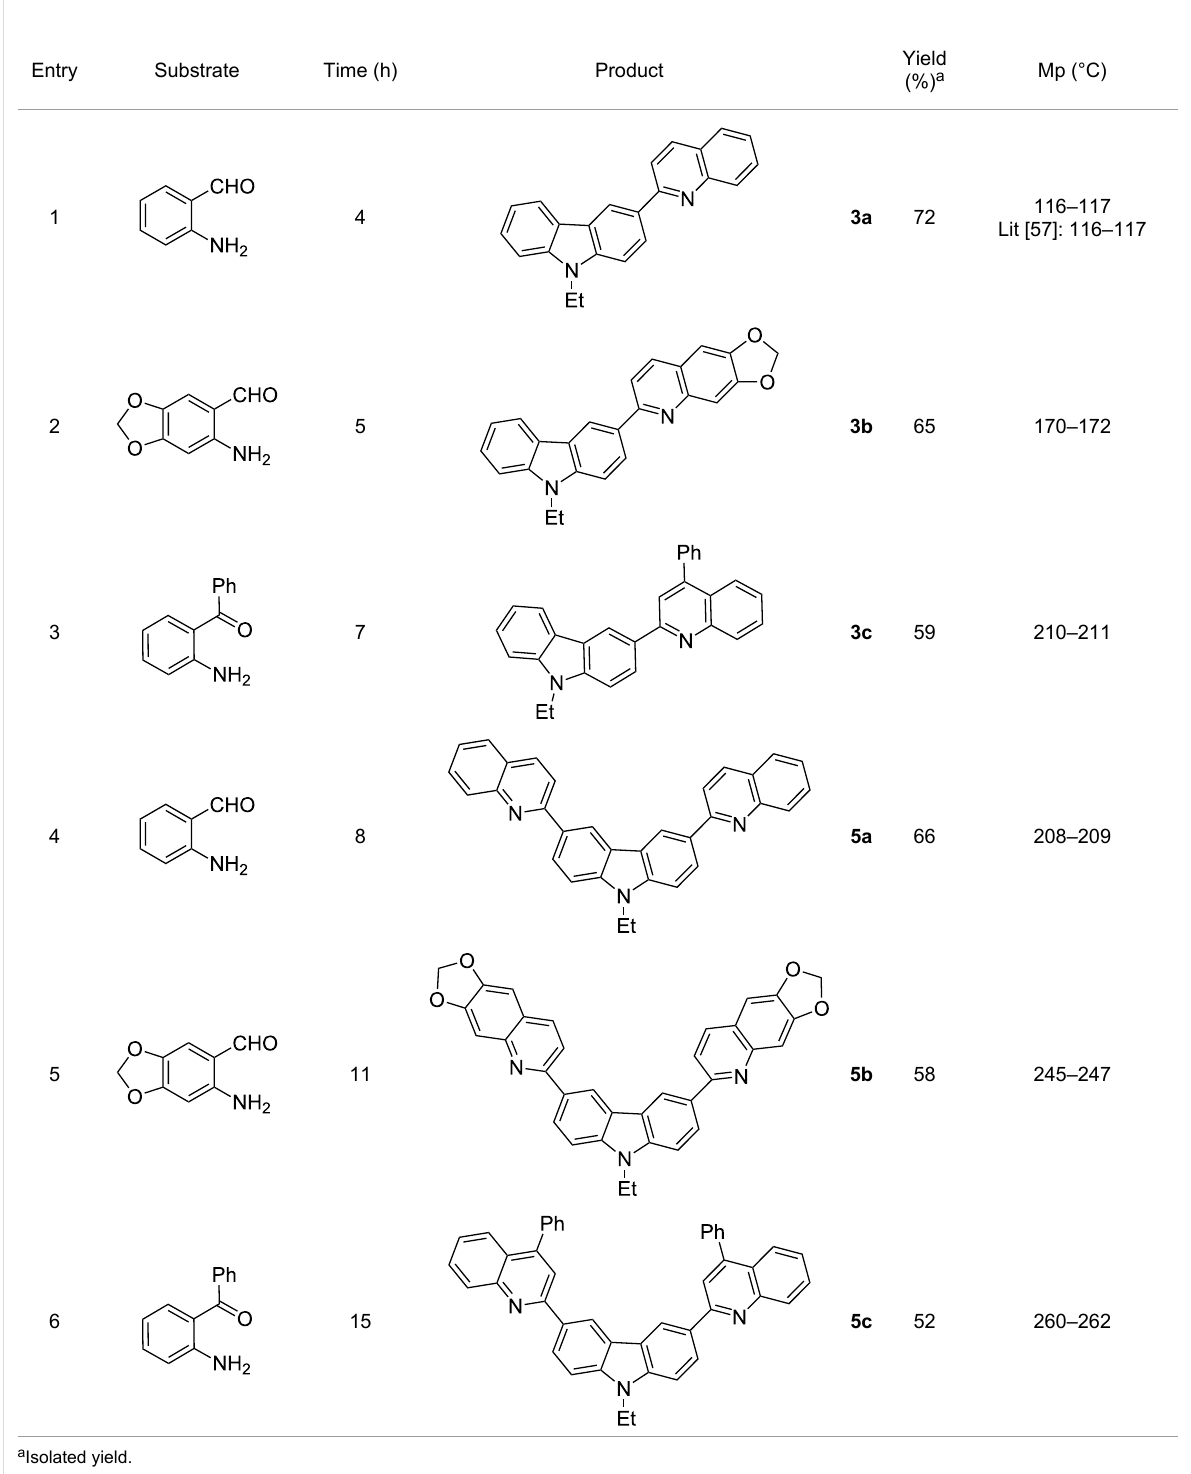
Table 1: Syntheses of 3-(quinolin-2-yl)- and 3,6-bis(quinolin-2-yl)-9 H -carbazoles ( 3a–5c